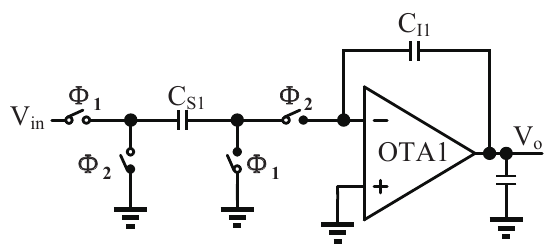
Figure 5. The switched-capacitor integrator circuit.